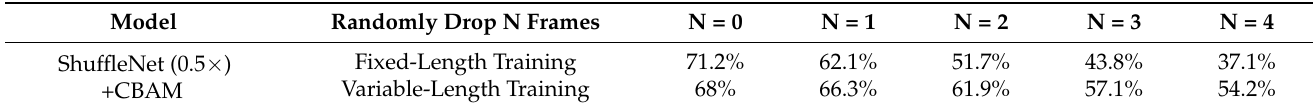
Table 5. Different performance of the model consisting of a ShuffleNet (0.5 × ) with